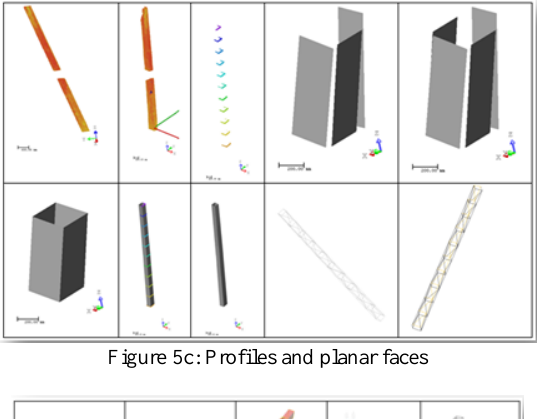
Figure 5c: Profiles and planar faces